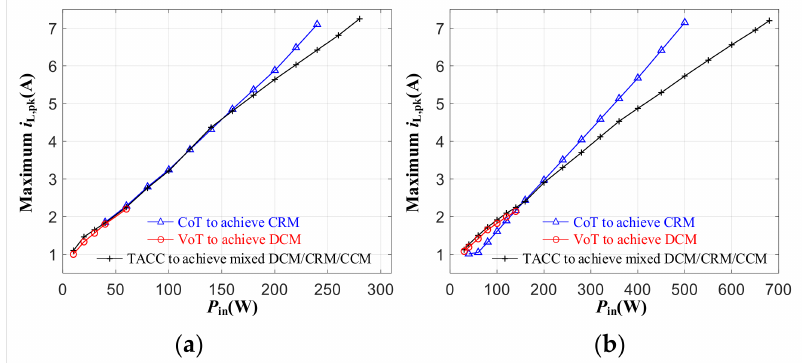
Figure 17. Maximum i L ,pk in a half-line cycle. ( a ) v in = 110 VAC; ( b ) v in = 220 VAC.